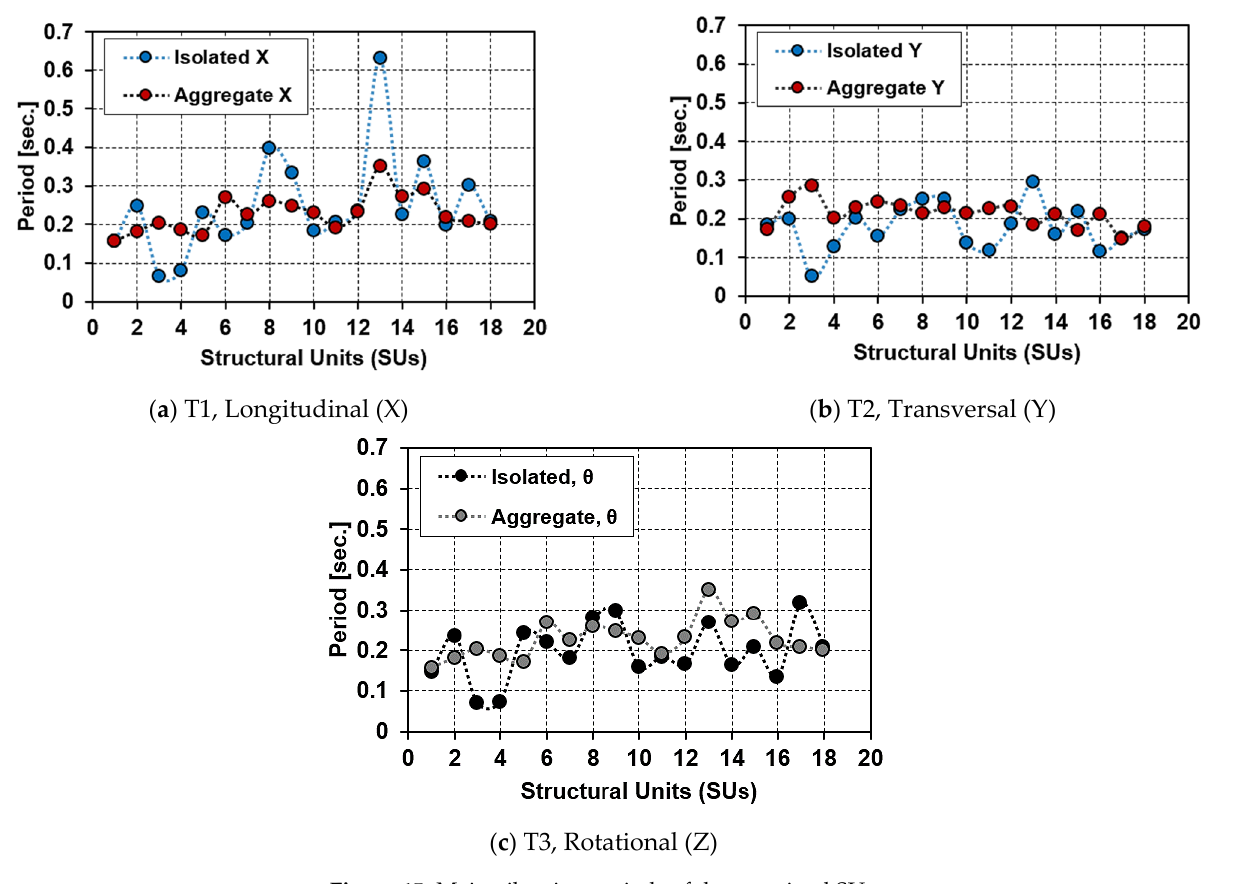
Figure 15. Main vibration periods of the examined SUs.